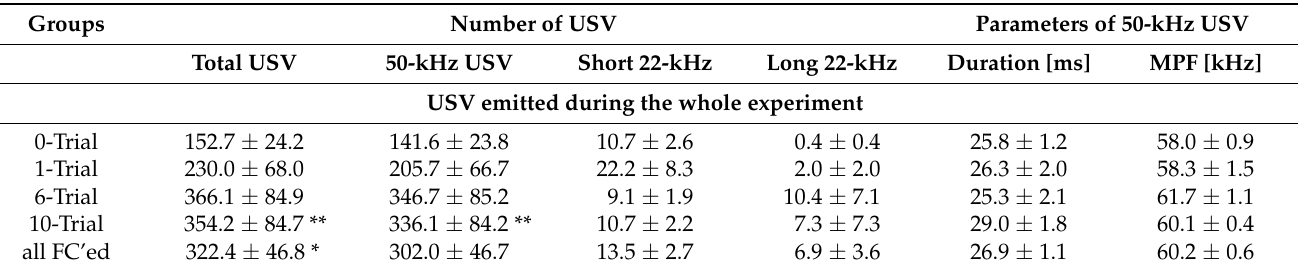
Table 1. Comparison of number of USV of different types and selected characteristics of 50-kHz USV emitted during the whole experiment, first 10 min of silence and during playback sessions, that is, during the 10-s-long playback and 110 s afterwards in response to 50- vs. 22-kHz USV, tone and sounds (averaged results) in control (0-Trial, n = 37) and fear-conditioned rats (1-Trial, n = 16; 6-Trial, n = 20; 10-Trial, n = 19; all fear-conditioned/FC’ed). MPF—mean peak frequency; categories of USV: 50-kHz (MPF >32 kHz), short 22-kHz (MPF of 18–32 kHz, duration <0.3 s), long 22-kHz (18–32 kHz, >0.3 s); underlined: effect of group showed by the Kruskal–Wallis test; * p < 0.05; ** p < 0.01, differences between 0-Trial and other groups; # p < 0.05, the difference between 1-Trial vs. 10-Trial groups, all Mann–Whitney test. Please note, USV emitted by FC rats are more numerous, prolonged and, usually, of higher